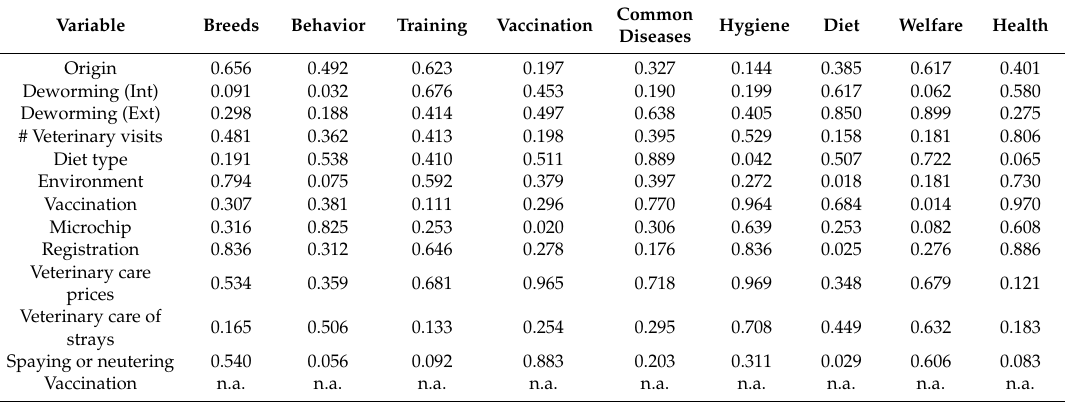
Table A2. Likelihood ratios between the interests of owners and other variables.